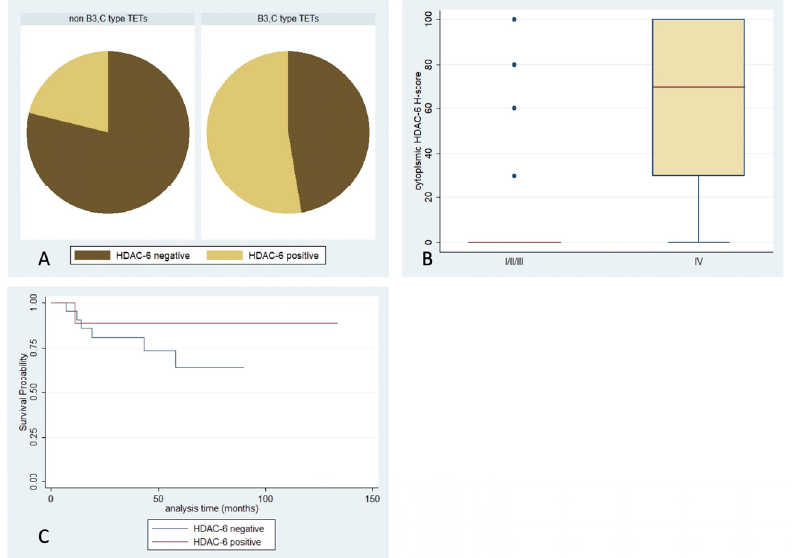
Figure 7. Schematic representation of the associations between cytoplasmic HDAC6 H-score and ( A ) WHO histological type, ( B ) Masaoka–Koga stage, and ( C ) patients’ overall survival.